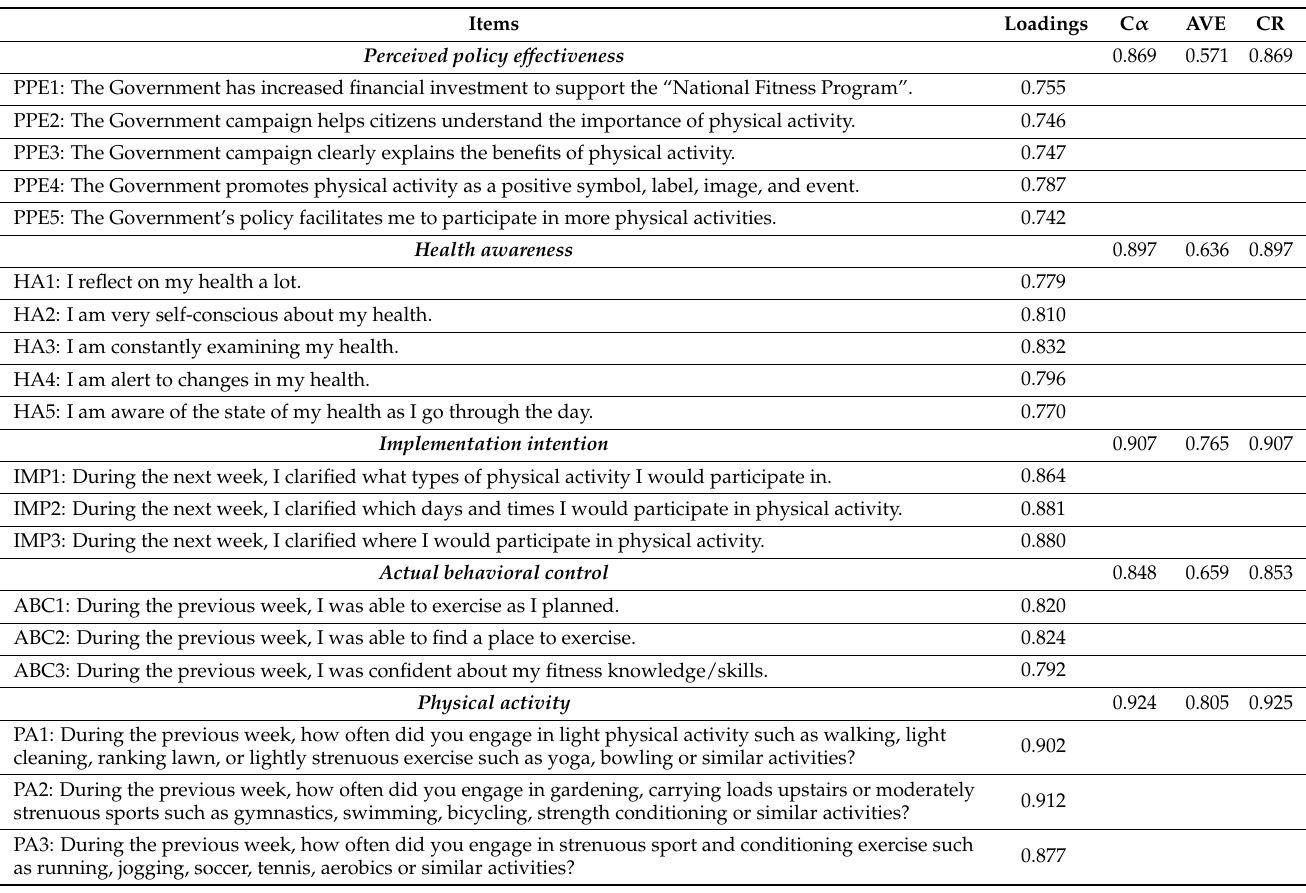
Table 2. Reliability and validity tests.